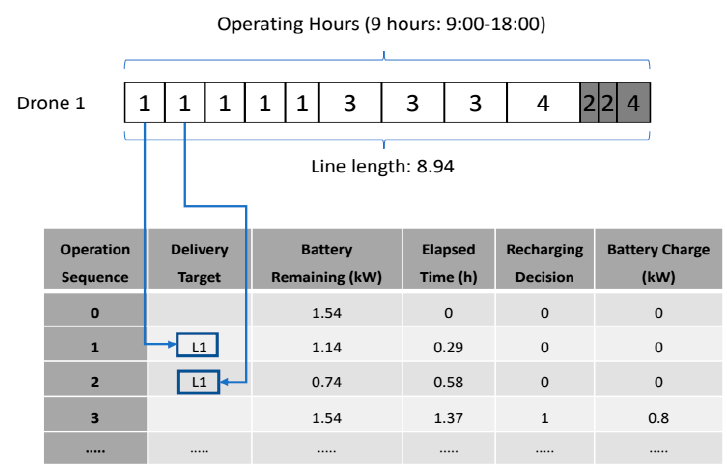
Figure 4. Final schedule generation